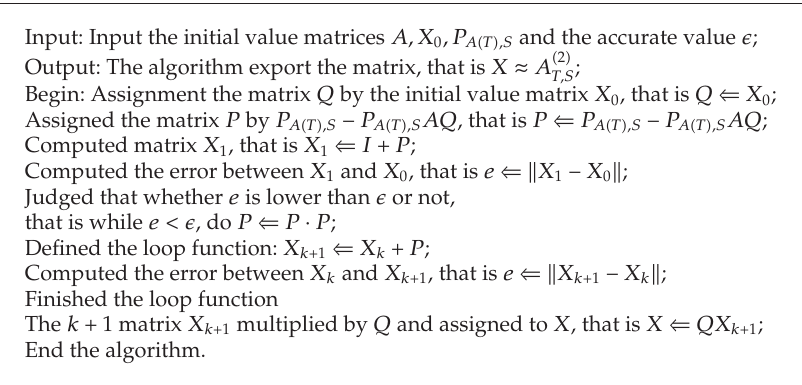
(cid:2) 2 (cid:3) T,S